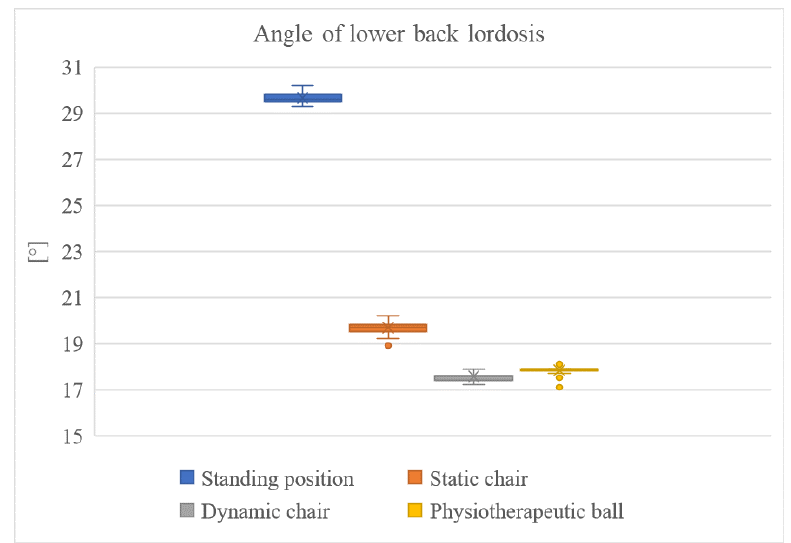
Figure 9. Range of values of the observed body parameters.